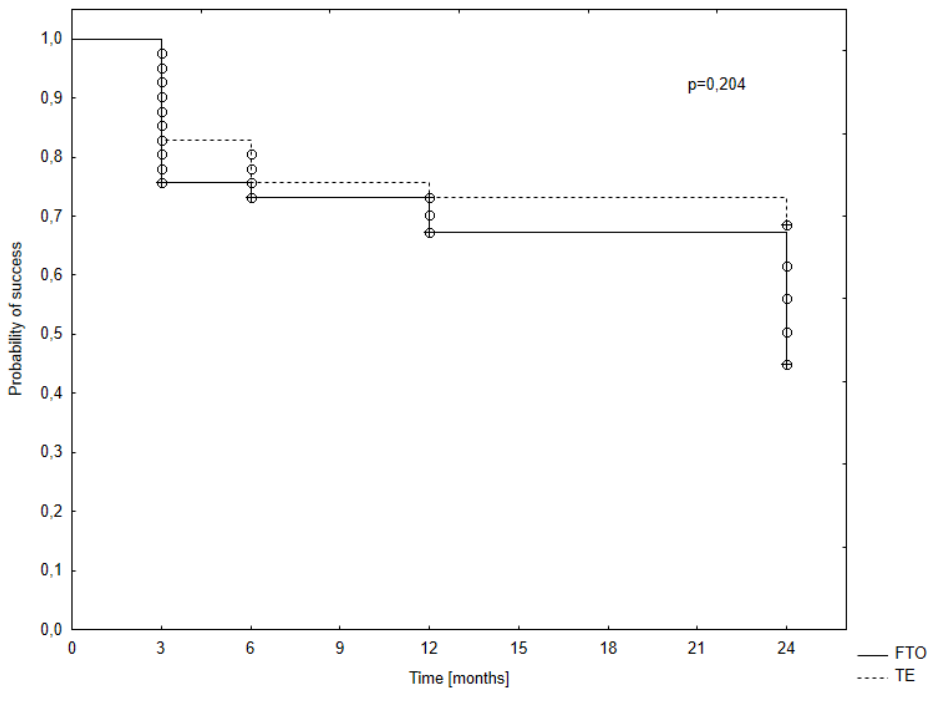
Figure 2. Kaplan-Meier curve for qualified success in FTO and